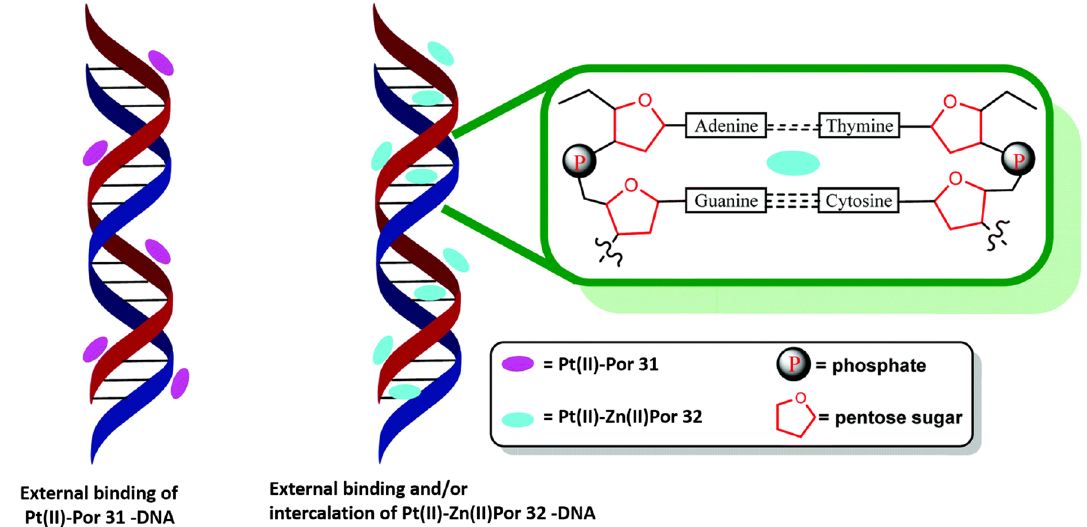
Figure 29 - Proposed possible binding modes of Pt(II)-Por 31 and Pt(II)-Zn(II)Por 32 with DNA. Reproduced from Lourenço et al. 2015 with permission of The Royal Society of